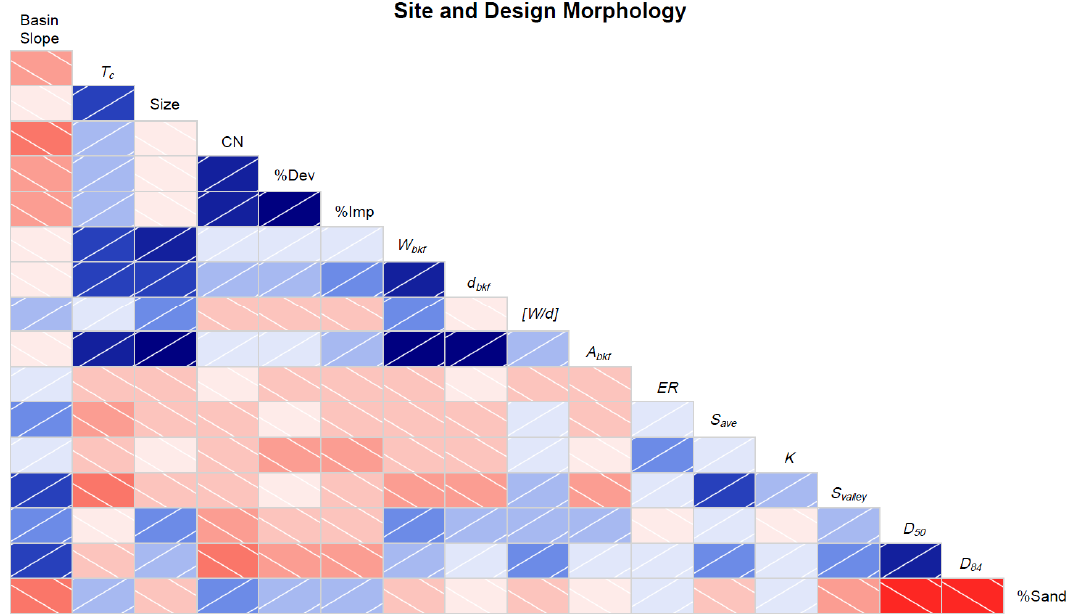
Figure 3. Correlation matrix diagram for 11 landscape and design morphology and six watershed variables. Blue indicates positive and red indicates negative correlation. Darker shades represent higher levels of correlation between